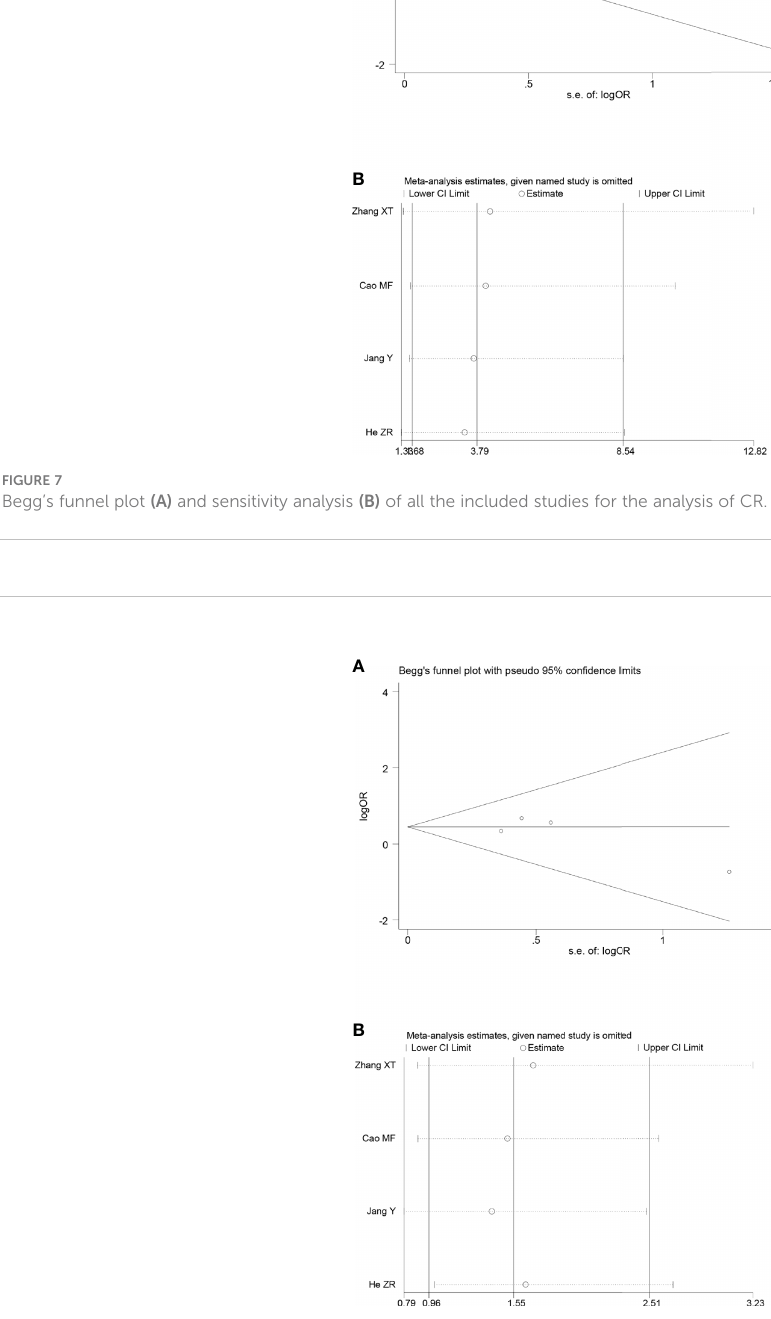
FIGURE 8 Begg ’ s funnel plot (A) and sensitivity analysis (B) of all the included studies for the analysis of the R0 resection